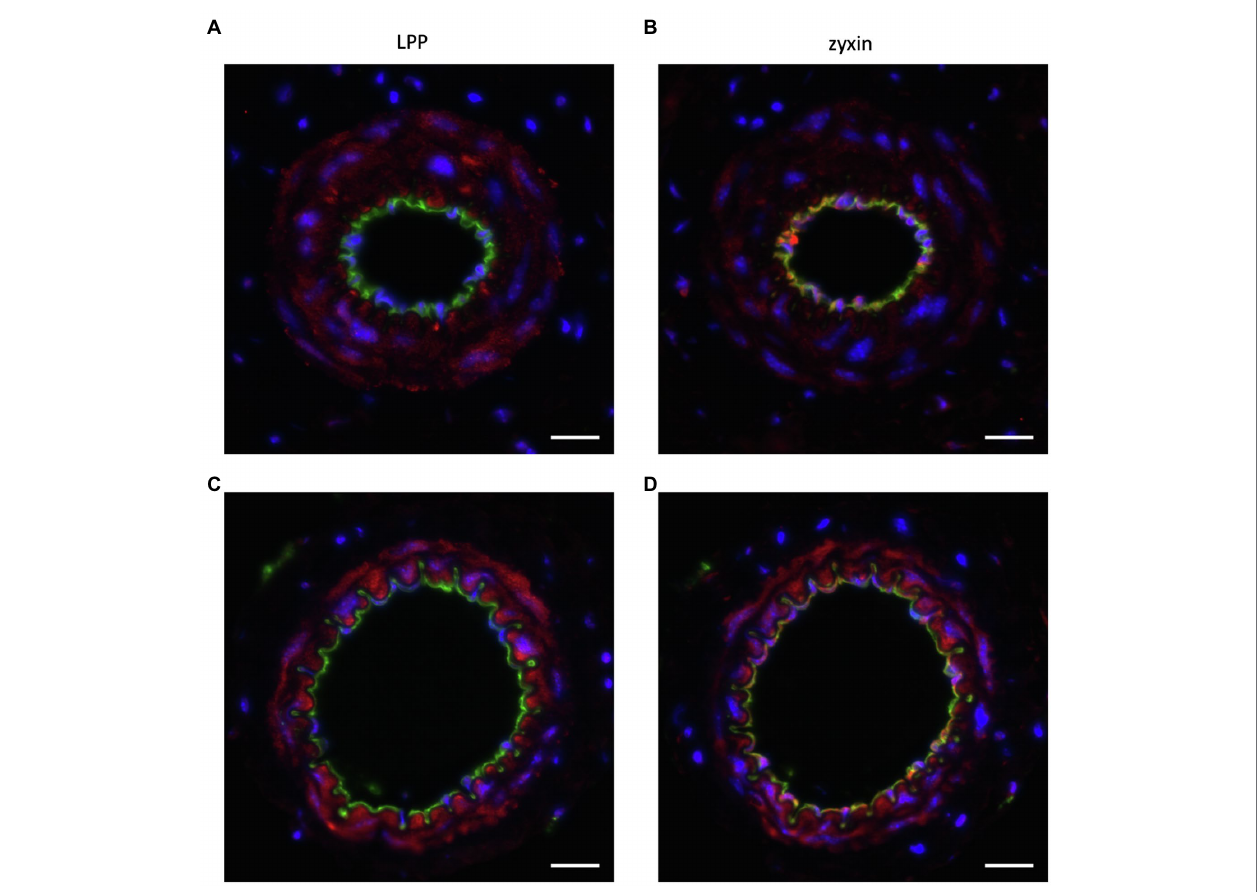
FIGURE 6 | Representative immunofluorescence analysis of the cellular distribution of (A , C) LPP and (B , D) zyxin in cross sections of the (A , B) mouse femoral and (C , D) mouse mesenteric artery. The isolated blood vessels were fixed with p -formaldehyde overnight, embedded in paraffin, and 3 µm-thin sections were stained with primary antibodies directed against LPP (HPA017342, Sigma-Aldrich, 1:75) or zyxin (HPA004835, Sigma-Aldrich, 1:75) together with primary antibodies directed against α -SMA (F3777, Sigma-Aldrich, 1–200) or CD31 (AF3628, R&D Systems, 1:200). Nuclei were counterstained with DAPI (blue fluorescence). Images were recorded using an Olympus IX3 epifluorescence microscope. The size marker corresponds to 20 μ m. LPP (red fluorescence) selectively localizes to the medial SMC layer of both arteries ( α -SMA-positive area, not shown), whereas zyxin (red fluorescence) is detected both in the intimal layer, that is, in the EC, and in the medial layer of both arteries. In particular in the femoral artery, there is a clear co-detection of zyxin and CD31 (green fluorescence) as indicated by the yellow fluorescence. Since CD31 is present in the EC membrane, while zyxin localizes to the cytoplasm and/or the nucleus, the remainder of the EC reveal positive CD31 immunoreactivity right next to that of zyxin. This also holds true for the mesenteric artery with some yellow fluorescence detectable, too. When compared to LPP, zyxin immunofluorescence in the medial SMC layer of both arteries is clearly